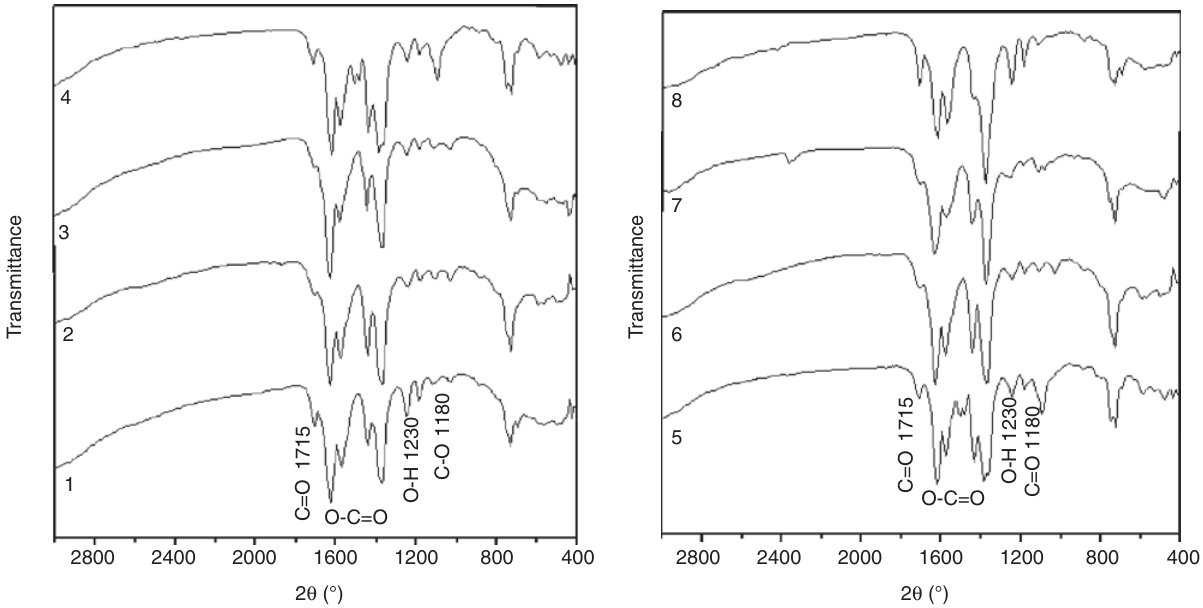
Figure 8: IR spectra of Cu-BTC, formed from Cu and benzene-1,3,5-tricarboxylic acid, under the effect of hydrate process [dry at 40 ° C (1), immersion 0 min (2), 20 min (3), 30 min (4), 4 h (5), 13 h (6), 18 h (7) and 24 h